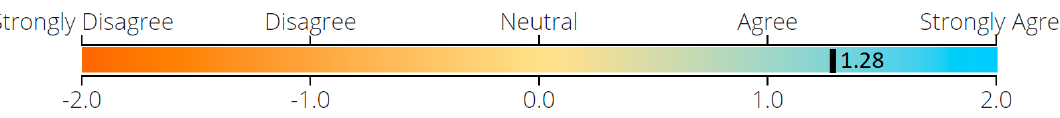
Figure 9. The average score from all participants’ answers when asked if they would recommend this type of Serious Game for stakeholders—range [1,2] and standard deviation 0.46. type of Serious Game for stakeholders—range [1,2] and standard deviation 0.46. type of Serious Game for stakeholders—range [1,2] and standard deviation